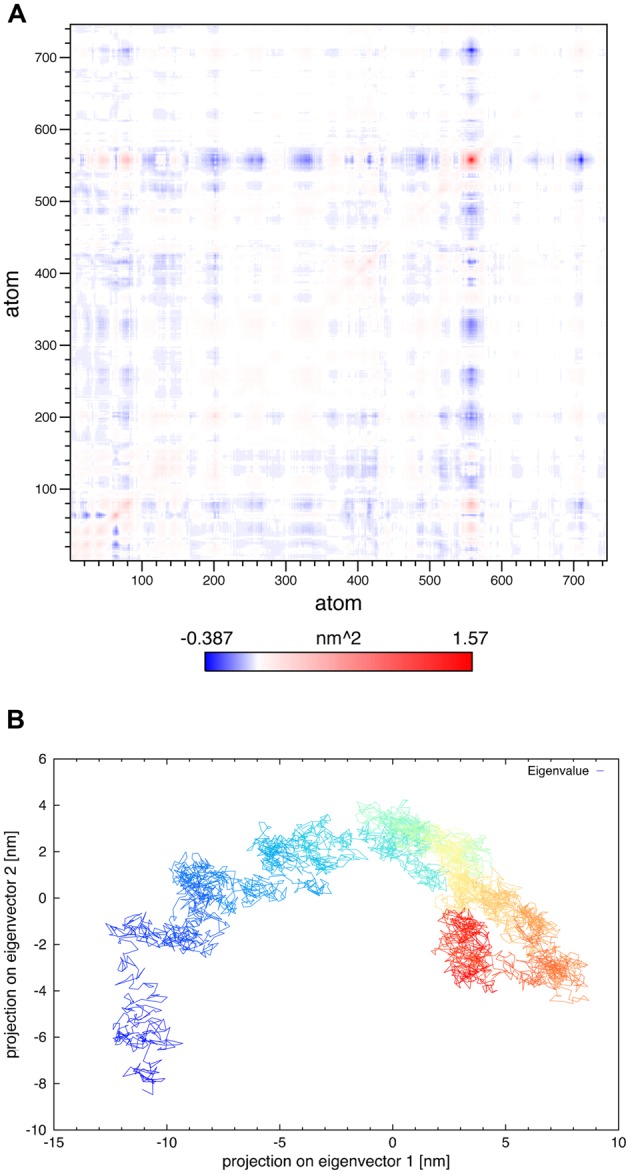
PCA analysis. (A) Variance–covariance matrix of the SV2A α-carbon atoms for the 50 ns of the MDS. (B) Projection of the 50 ns trajectory onto the two principal eigenvectors obtained from the diagonalization of variance–covariance matrix; time along the trajectory is represented by a denser gradient.